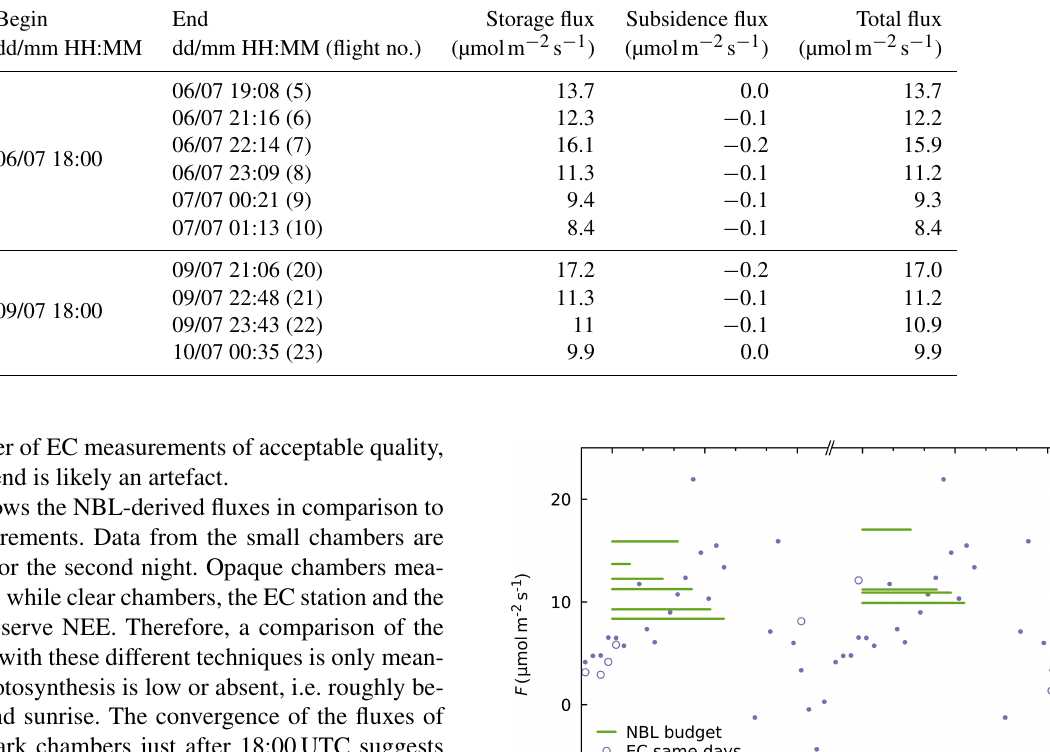
Table 3. Fluxes of CO 2 calculated from NBL budgets. Begin and end times are given in UTC. The end time is specified as the midtime of the portion of the flight used for determination of the NBL budget. Begin